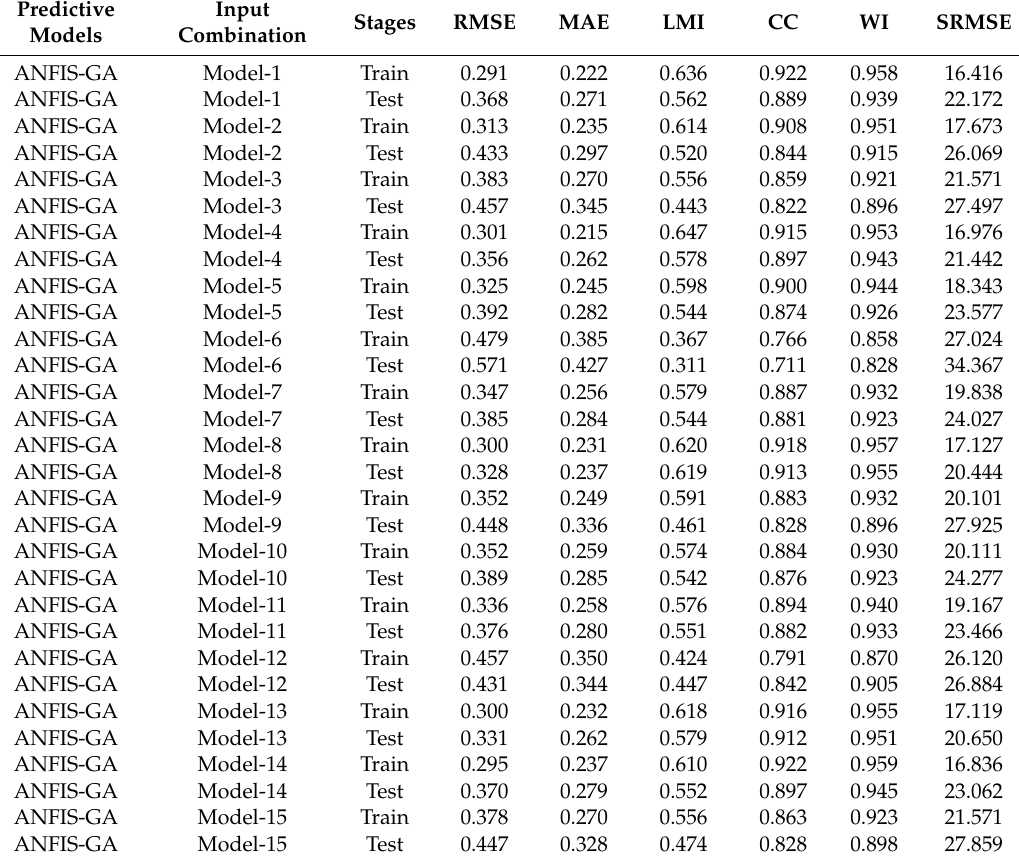
Table5. ThepredictionperformanceofthehybridANFIS-GAmodelforallproposedinputcombinations over the training and testing stage. The boldface denotes the best modeling